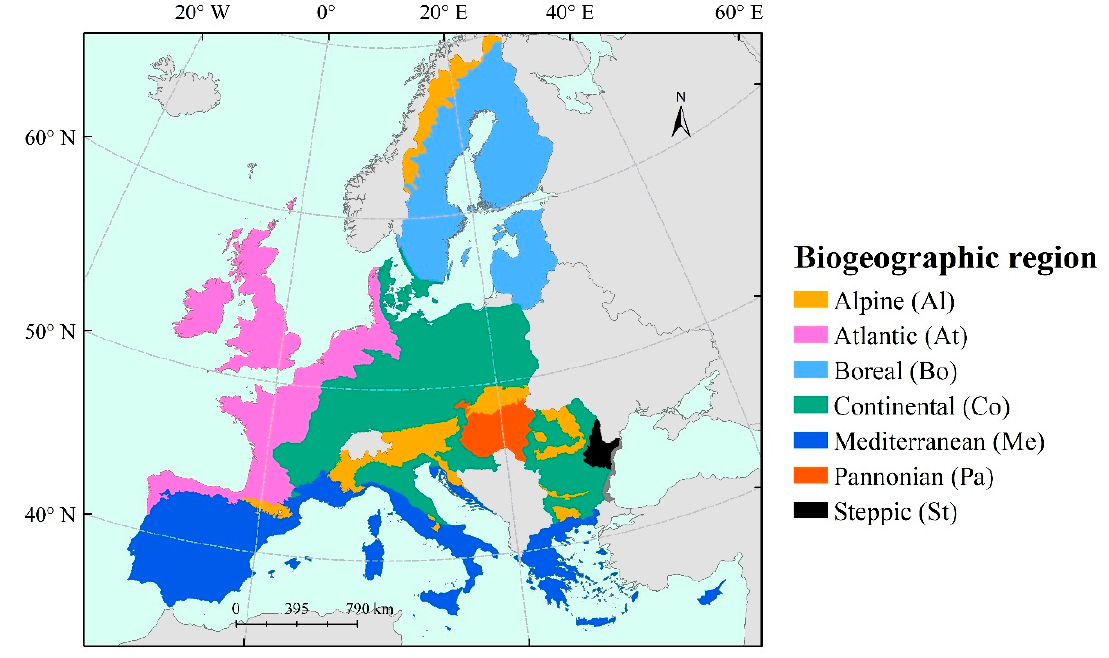
Figure 1. Study area and biogeographical regions [32].